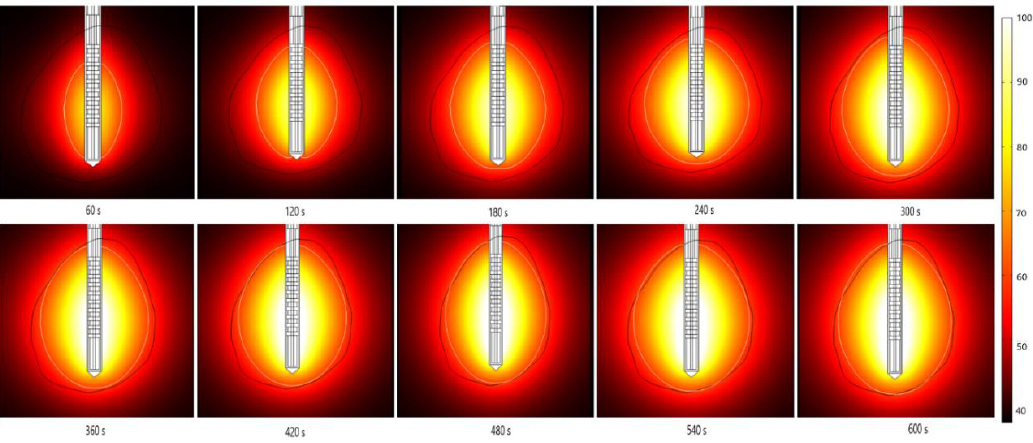
Figure 8. Temporal evolution of the temperature (in ◦ C) when an early-stage HCC [70] is treated by microwave ablation at a frequency of 2.45 GHz and input power of 13 W in y–z cut plane. The boundary of the tumor tissue is marked by the black line.